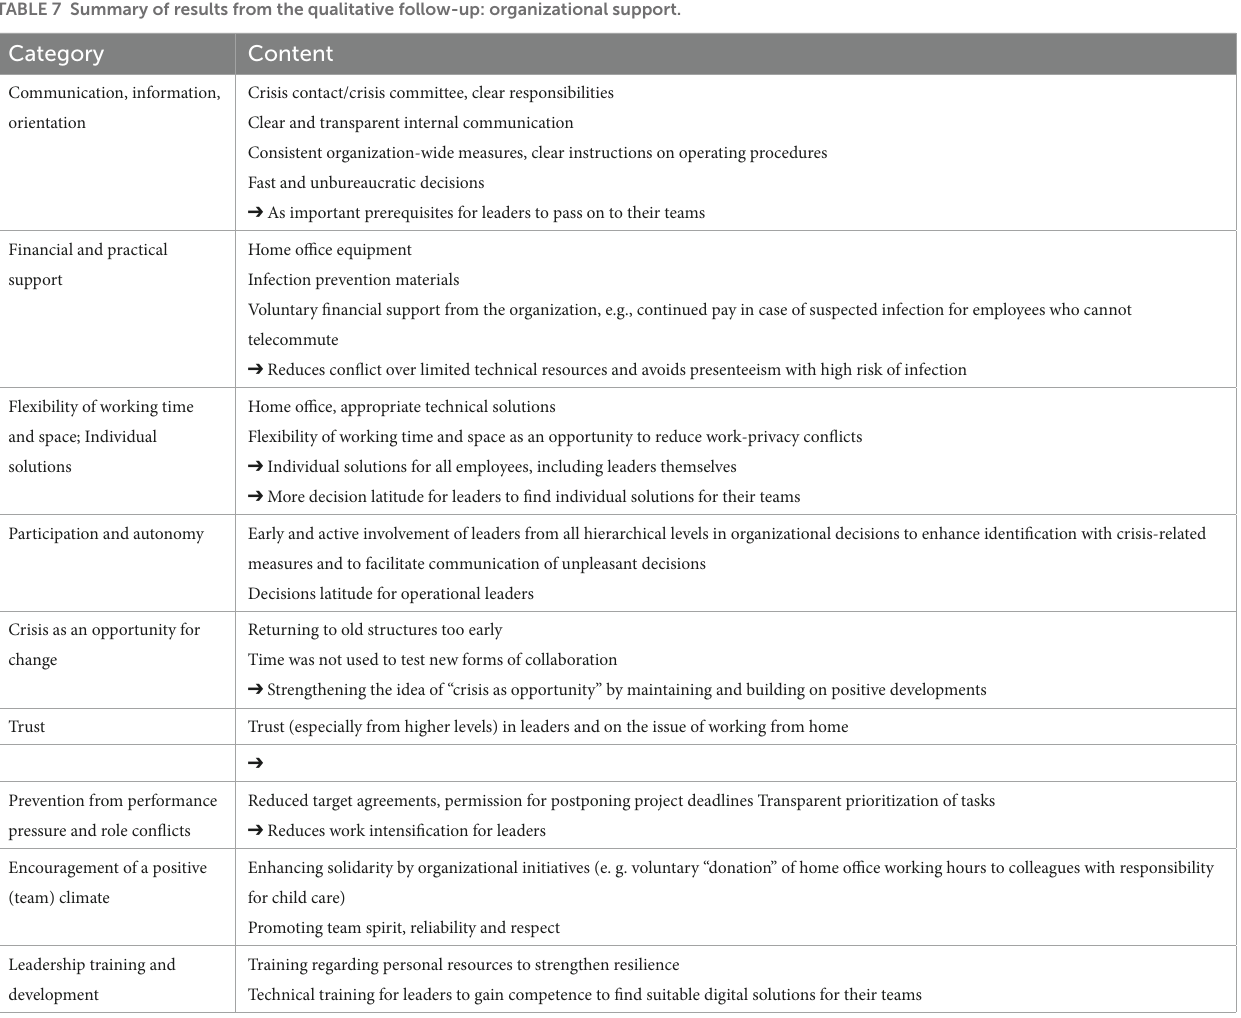
TABLE 7 Summary of results from the qualitative follow-up: organizational support. Category